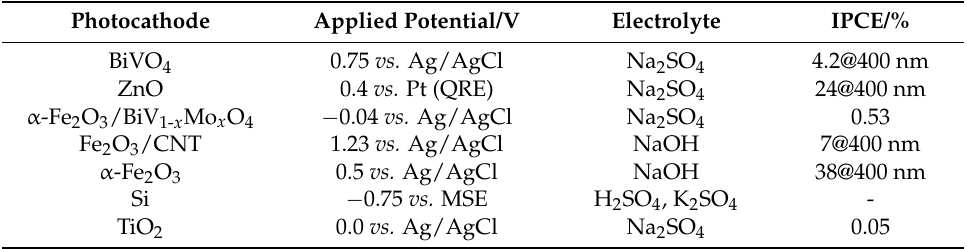
Table 4. Semiconducting materials combined with RGO as photocathodes of PECs generating H 2 . Illumination source is a Xe lamp with 1.5 AM spectrum. PECs, photoelectrolysis conditions and spectral conversion efficiencies are also reported. Data extracted from reference [123] and references therein. Photocathode Applied